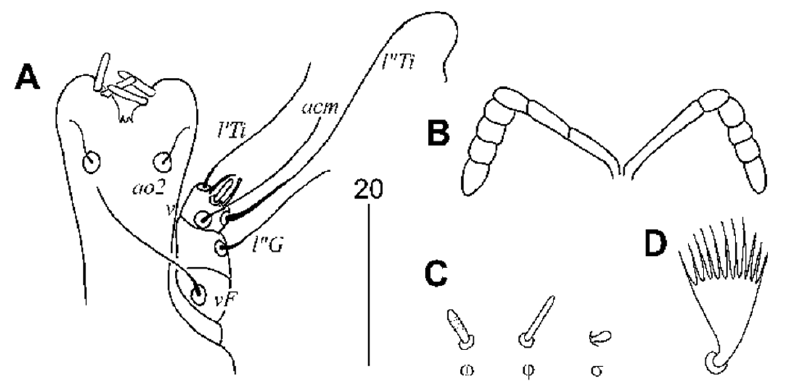
Figure 3. Peristerophila mayri Skoracki and Hromada sp. n., female. ( A )—gnathosoma in ventral view; ( B )—peritremes; ( C )—solenidia of leg I; ( D )—fan-like seta p’III. Ex Little Green Bee-eater Merops orientalis (host in the ZSM, uncatalogued); Sri Lanka: Anuradhapura, 7 January 1905, coll. Doflein; two females (HET) deposited in the AMU (reg. no. Homeomorphic Female and Male Not found.